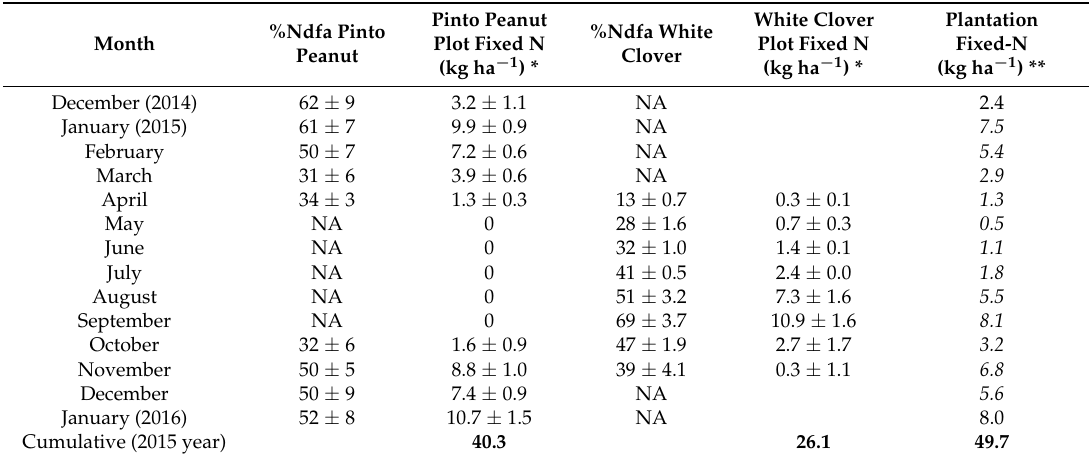
Table 2. %Ndfa and N fixed per month for Pinto peanut and white clover at the Alstonville site. Means are followed by standard errors ( n =